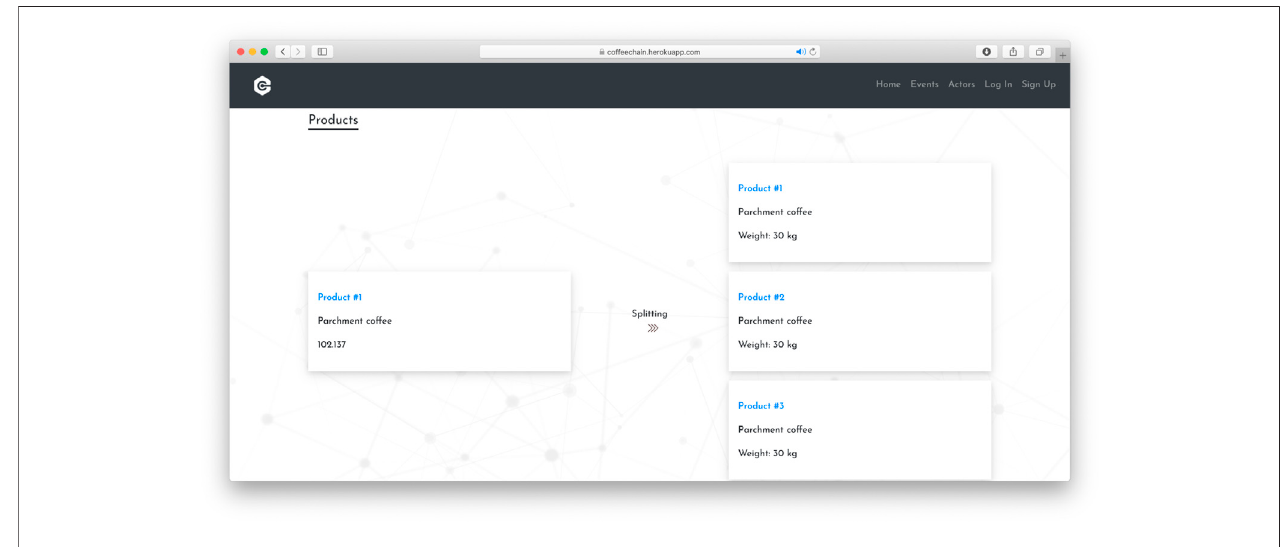
FIGURE 4 | Event view of